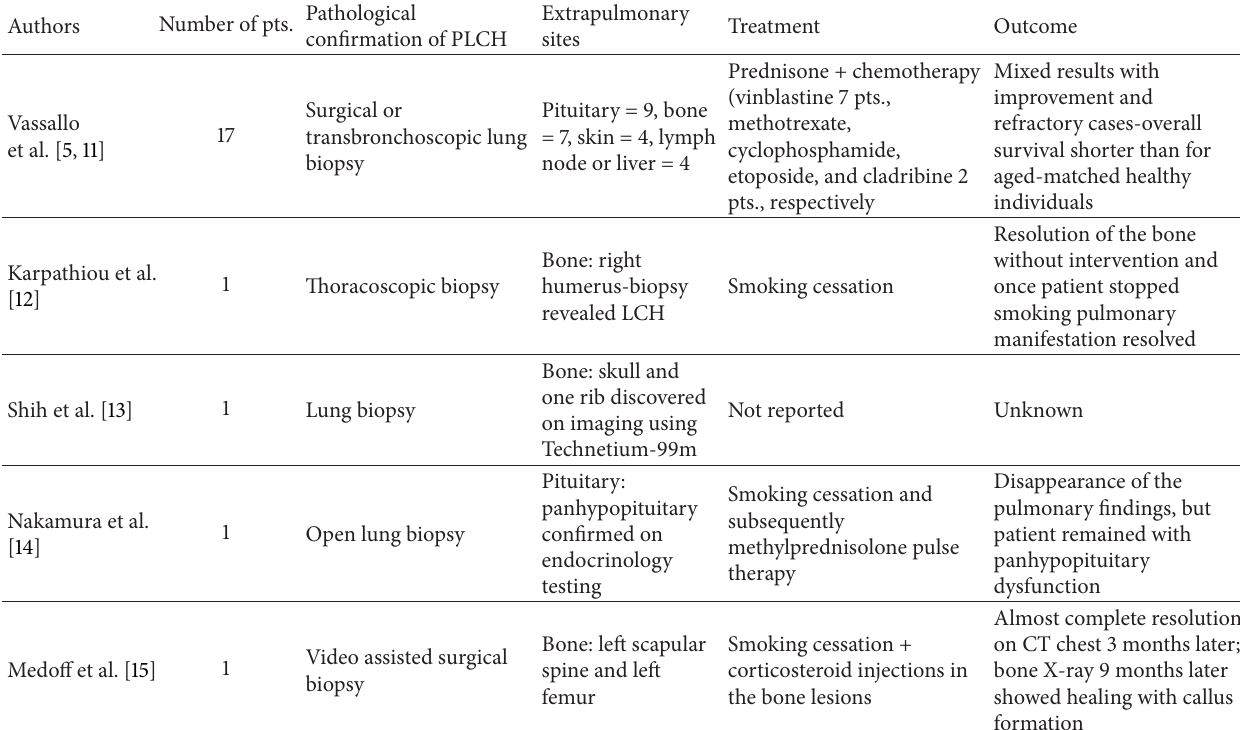
Table 1: Studies on pulmonary Langerhans cell histiocytosis with extrapulmonary manifestations. Pathological Authors Number of pts. confirmation of